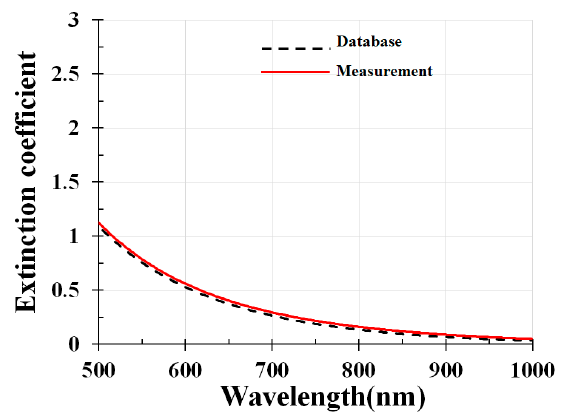
Figure A4. The extinction coefficients of a-Si versus wavelength from measurement and database.